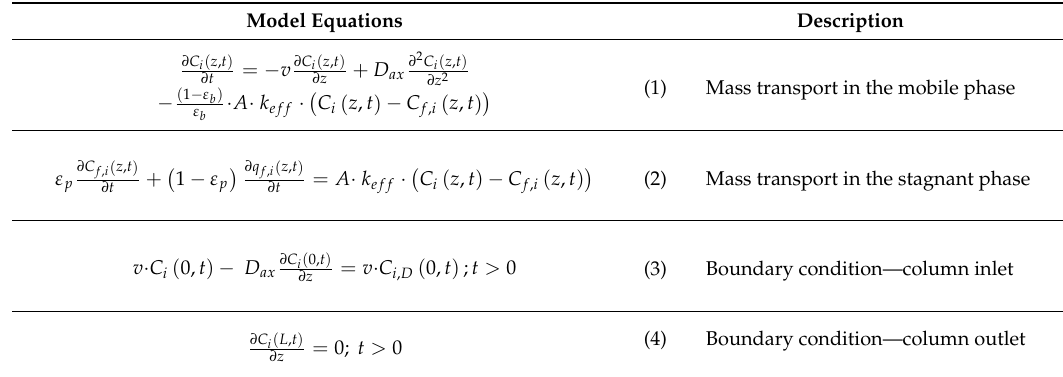
Table 1. Summary of the relevant model